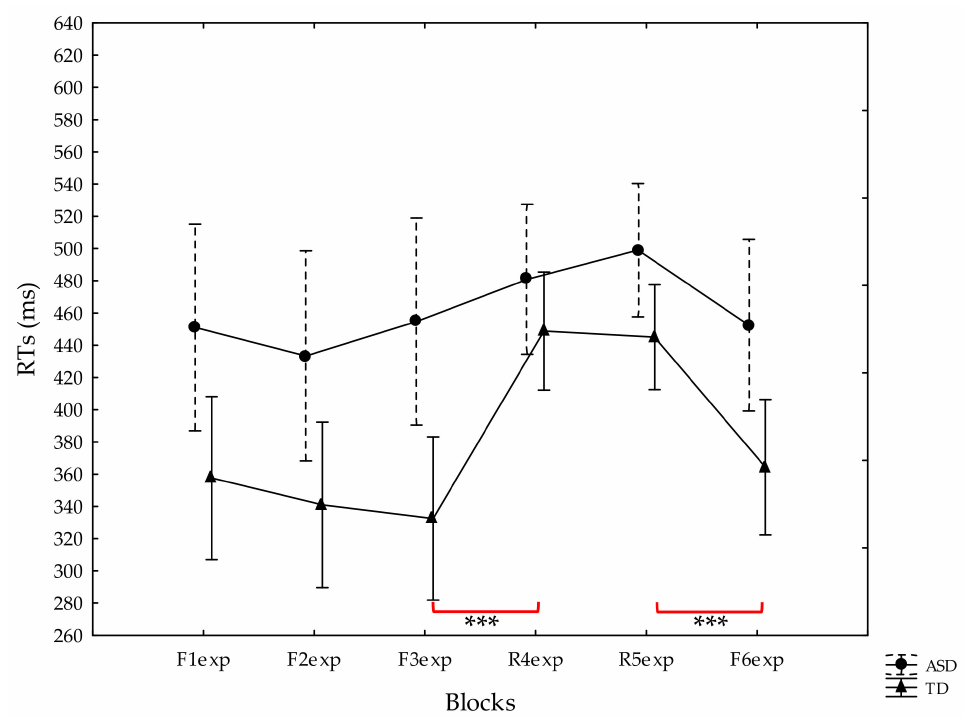
Figure 2. Reaction times (RTs) of the participants with ASD (circles) and TD (triangles) in the Explicit Memory Serial Reaction Time Task. Vertical bars denote standard errors. *** p <